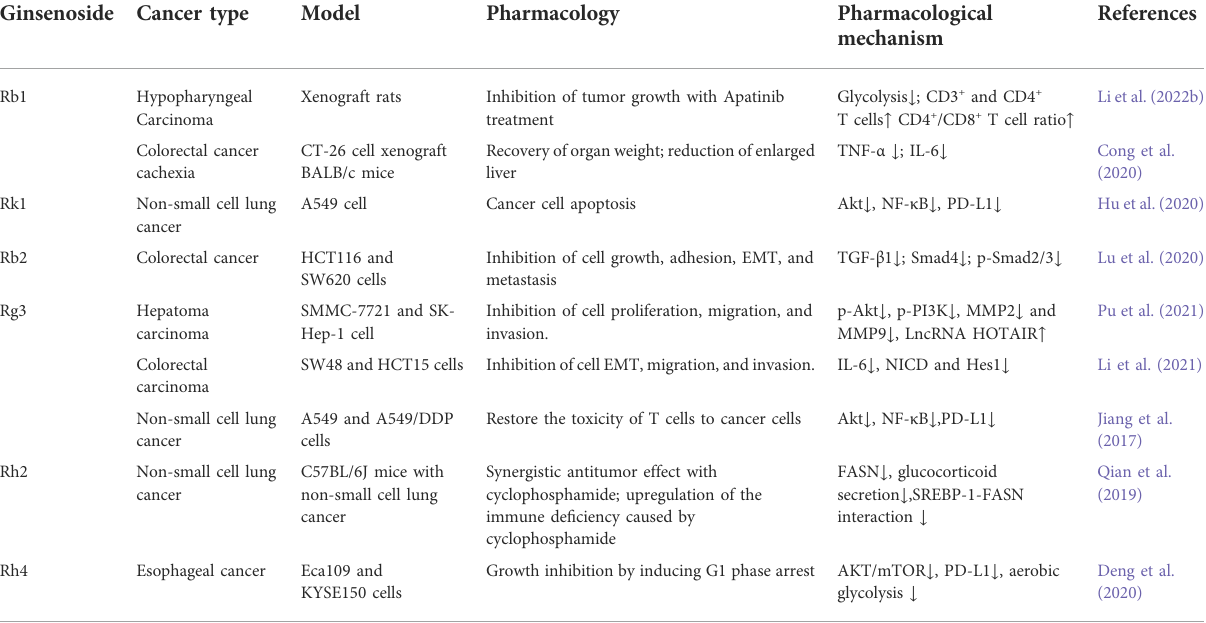
TABLE 2 Immune-related pharmacological activities/mechanisms of